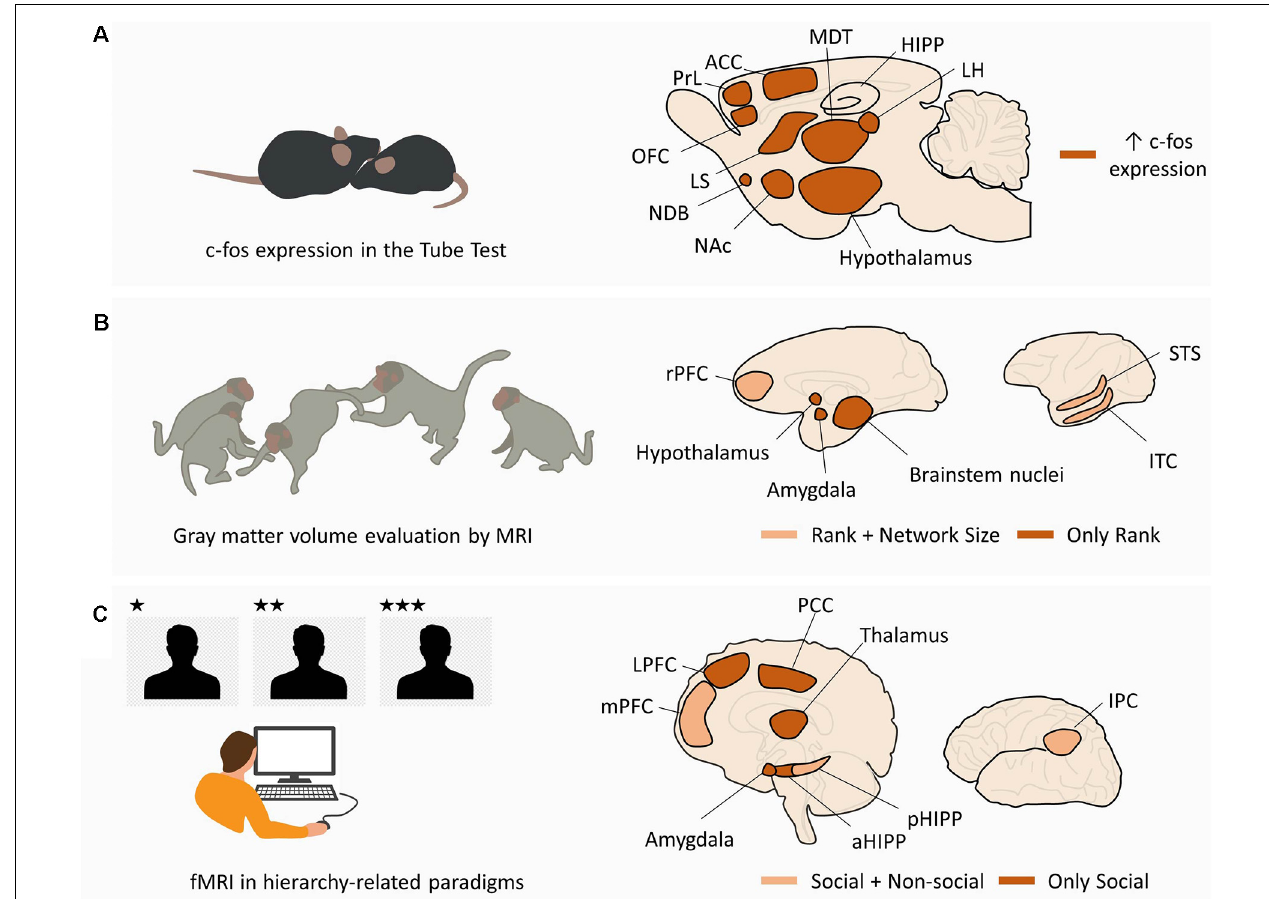
FIGURE 2 | Macroscale networks supporting social hierarchies. (A) Macroscale network in rodents. In mice performing tube tests for social hierarchy, c-fos expression in dominant animals is increased in the ventromedial hypothalamus, LH, ACC, medial preoptic area (hypothalamus), and MDT. In addition, pairwise correlations were found between MDT-PrL, MDT-OFC, MDT-ACC, MDT-CA2, ACC-MDT, ACC-LH, ACC-NDB, ACC-LS, and ACC-NAc. (B) Macroscale network in non-human primates. MRI studies in non-human primates from different social statuses and living in groups of different sizes have shown a correlation between social rank and gray matter volume in the hypothalamus, amygdale, and brainstem nuclei (“Only Rank”). Gray matter volume in rPFC, STS, and ITC was correlated with both social rank and group size (“Rank + Network Size”). (C) Macroscale network in humans. fMRI studies in human subjects performing hierarchy-related tasks have shown selective activation of LPFC, amygdala, aHIPP, thalamus, and PCC by the social component of the task (“Only Social”). The mPFC, pHIPP, and IPC were activated in the social and non-social conditions, suggesting a domain-general function (“Social + Non-social”). See text for other domain-general regions in human literature not depicted in the figure. Abbreviations: LH, lateral habenula; ACC, anterior cingulate cortex; MDT, medial preoptic area (hypothalamus), and mediodorsal thalamus; PrL, prelimbic cortex; OFC, orbitofrontal cortex; NDB, nucleus of the diagonal band; LS, lateral septum; NAc, nucleus accumbens; rPFC, rostral prefrontal cortex; STS, superior temporal sulcus; ITC, inferior temporal cortex; LPFC, lateral prefrontal cortex; aHIPP, anterior hippocampus; pHIPP, posterior hippocampus; PCC, posterior cingulate cortex; mPFC, medial prefrontal cortex; IPC, inferior parietal